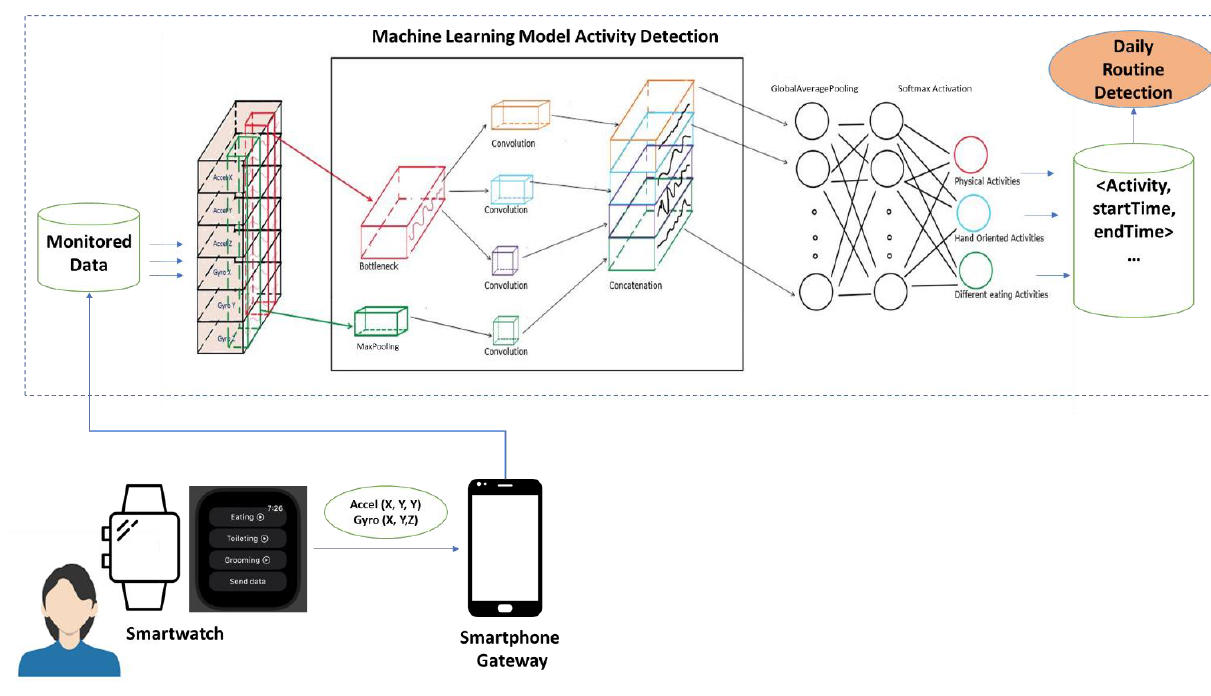
Figure 5. Architecture for data gathering and activity patterns detection. A smartwatch is used for collecting raw data that is ushed through a gateway (e.g., smartphone) in a cloud database.